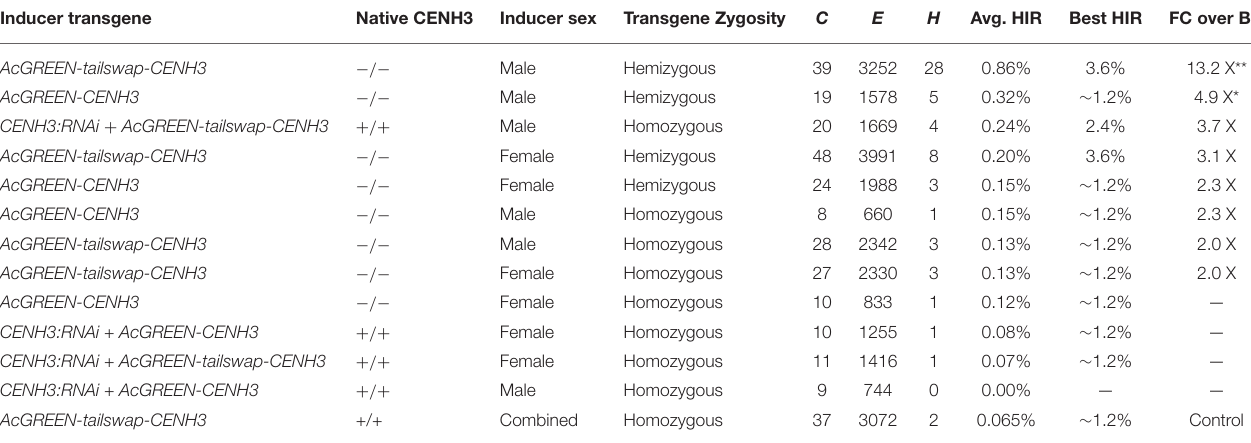
TABLE 5 | Summary of haploid induction rate data following outcrosses with CENH3 -altered transgenic maize lines. Inducer transgene Native CENH3 Inducer